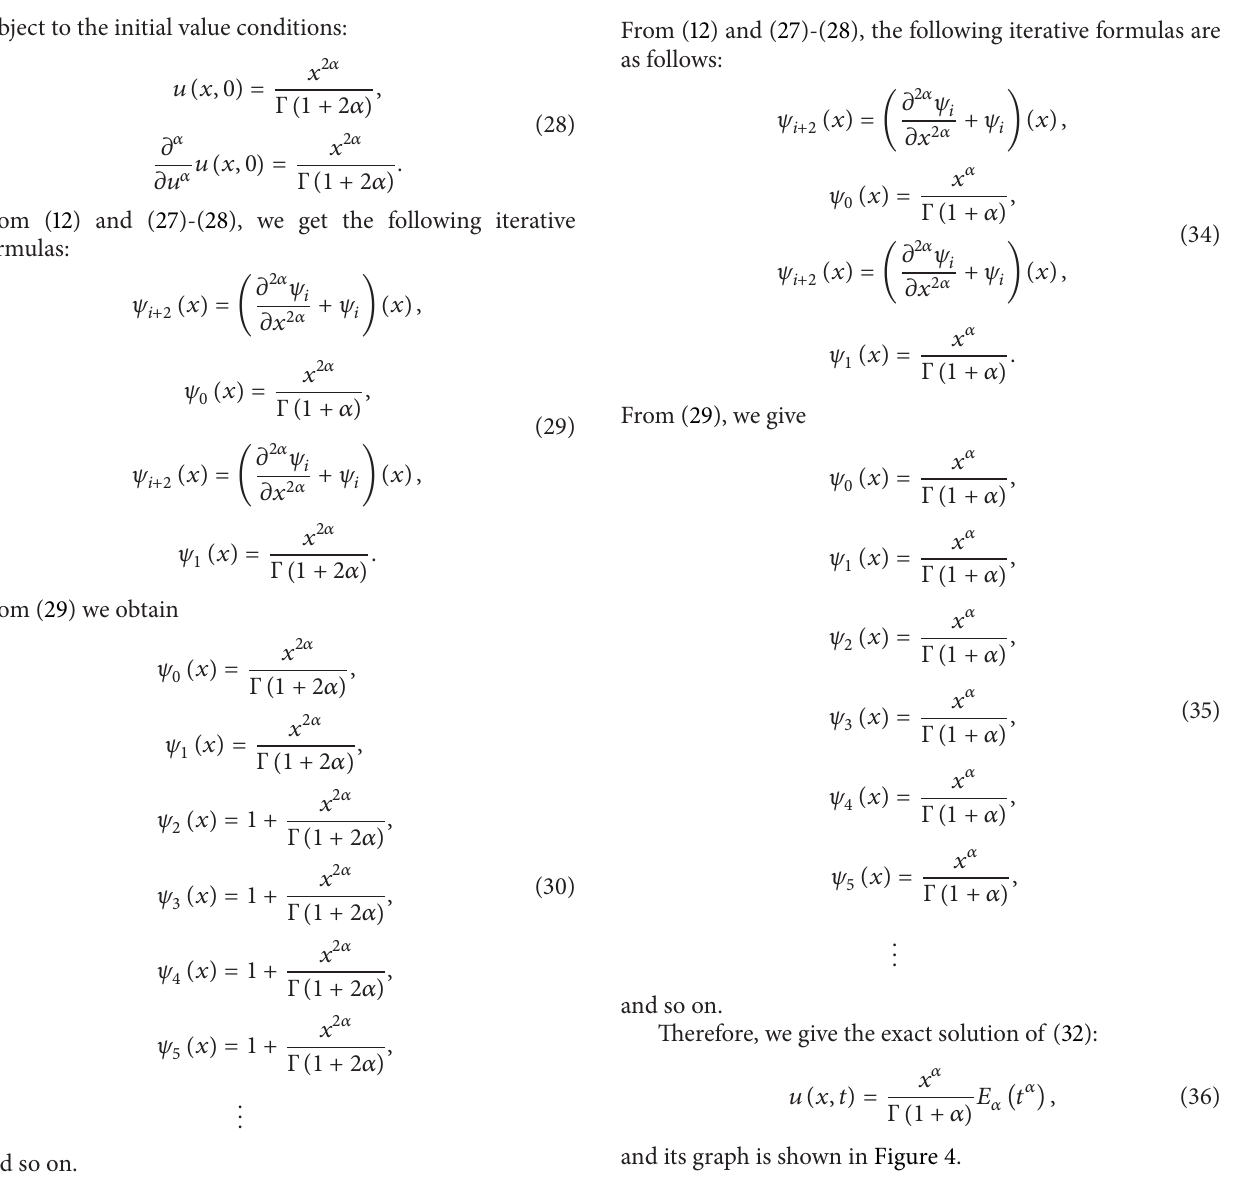
subject to the initial value